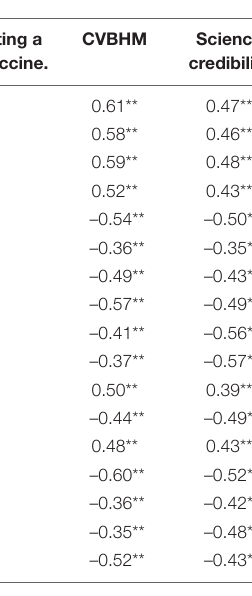
TABLE 6 | Relation of Vx receptivity attitudes to CVBHM, science credibility to probability of taking the COVID-19 vaccine (Study 1).